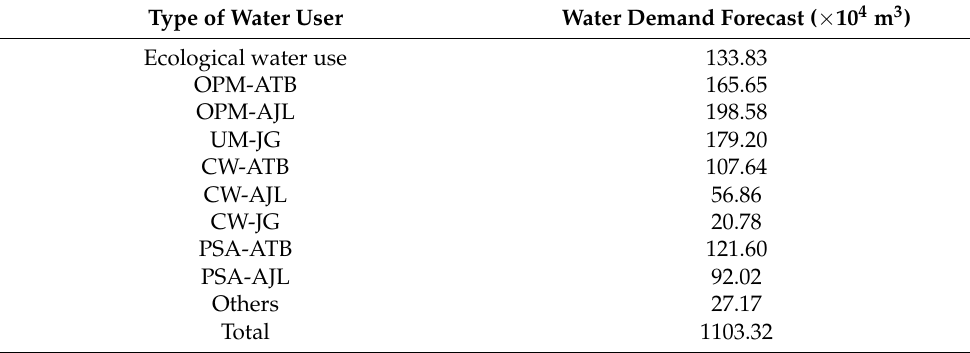
Table 7. Water demand forecast in 2030. The meaning of the abbreviations is shown in Table 3. Type of Water